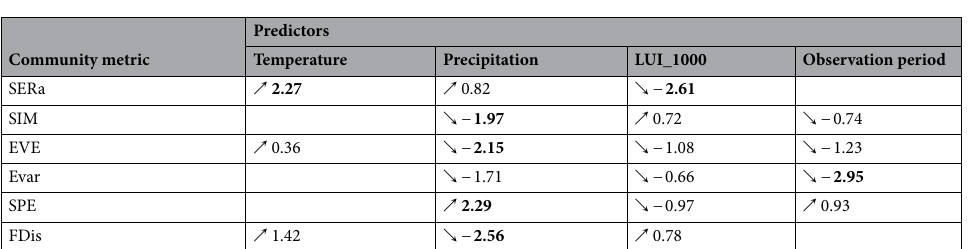
Figure 2. Overall trends in 21 community metrics representing changes in the taxonomic and functional composition of ground beetle communities over the last two decades at 40 sites in Germany. Grey dashed lines show 95% confidence intervals. Abbreviated community metrics on the y-axis are explained in Table 1.